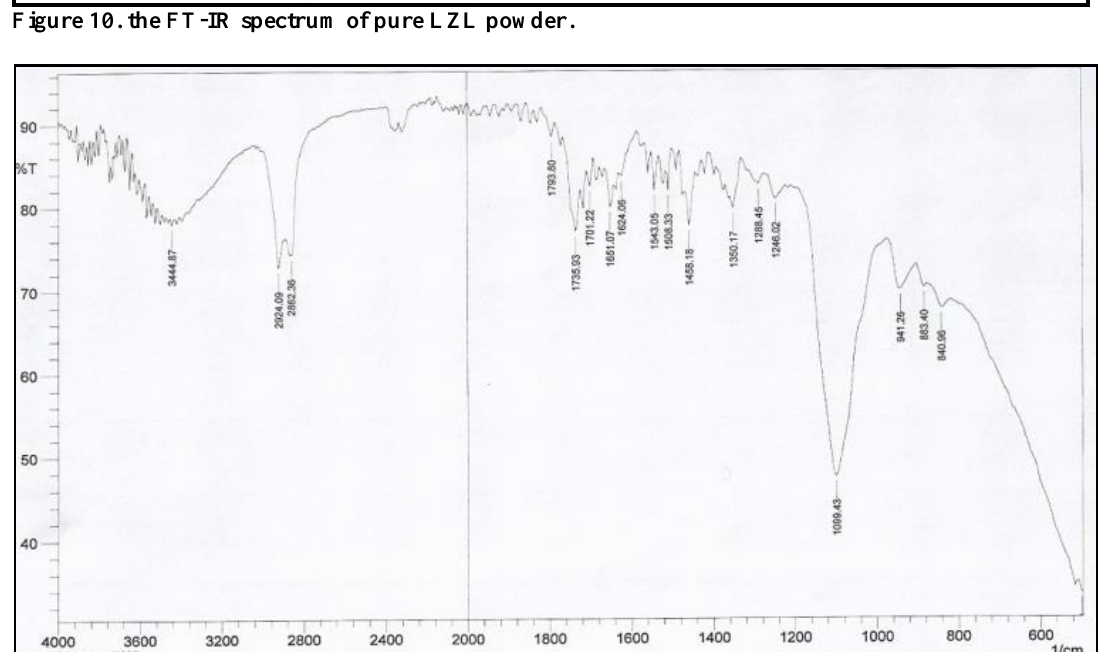
Figure 11.FT-IR spectrum of optimum formula NS-7 Field emission scanning electron microscopy ( FE-SEM ) FE-SEM is microscopy examined which can approve the particle size of optimum formula NS-7. As it clear from figure 12 the